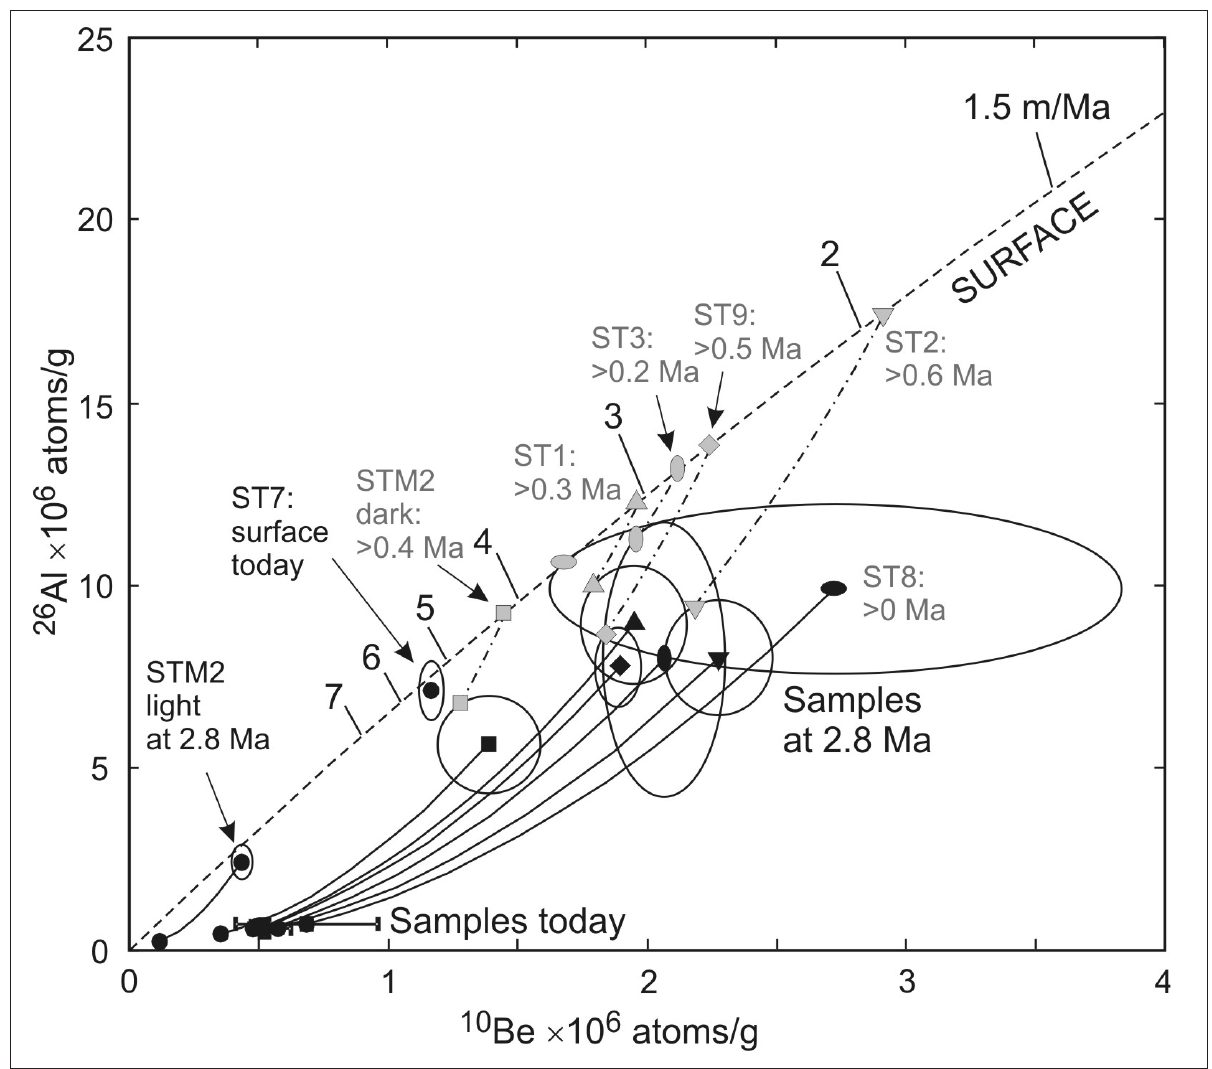
Figure 3: Back-correction of sample data in a two-stage burial model. Black symbols and solid curves show back-corrected decay paths of surface-derived samples and chert composite ‘STM2-light’ to 2.8 Ma, calculated using Equation 2 and in-situ 10 Be and 26 Al production rates corresponding to ‘ calc2’ values of Figure 1a. Error ellipses show 2 σ uncertainties, derived from Granger et al. 1 Data for ST7 (present-day surface sample of Granger et al. 1 ) is shown for comparison. Dashed curve ‘SURFACE’ shows surface steady-state 10 Be and 26 Al concentrations for a range of erosion rates. Grey dot–dash curves are decay paths in a hypothetical upper cave chamber, calculated back to their pre-burial values at surface, using in-situ 10 Be and 26 Al production rates corresponding to the concentrations of ‘STM2-light at 2.8 Ma’. Minimum times required to correct back to surface values, given for each sample, yield minimum residence times in the upper chamber. Note the error ellipse for sample ST8 touches the surface curve: minimum residence time is zero for this